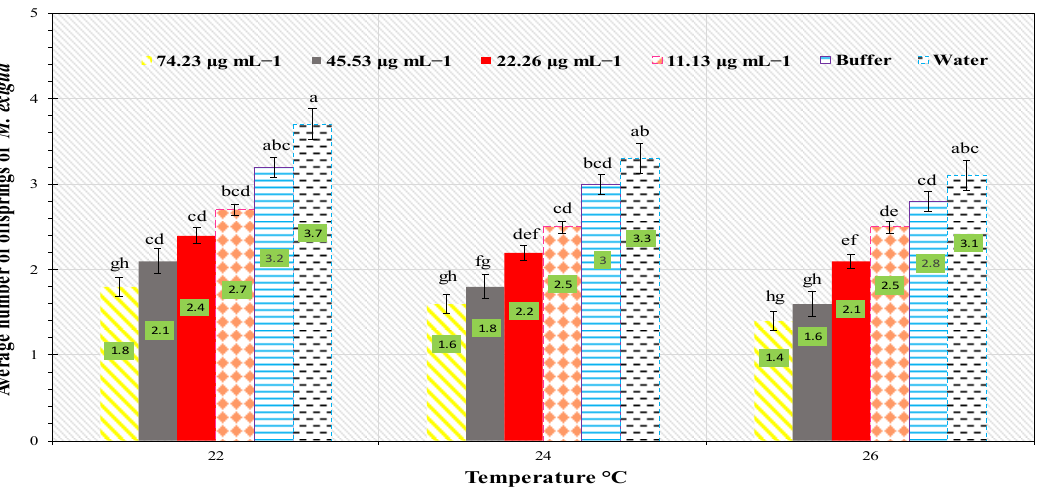
Figure 5. Average fecundity (mean ± SE) of C. exigua on O. sativa seedlings in relation to various PeBL2 elicitor concentrations, at different temperature regimes ( n = 10). (a–h) small letters on each bar are significant differences among treatments and control, Data were compared statistically; the LSD, ANOVA, and Leven’s test were employed by Statistix version 8.1 at α = 0.05).